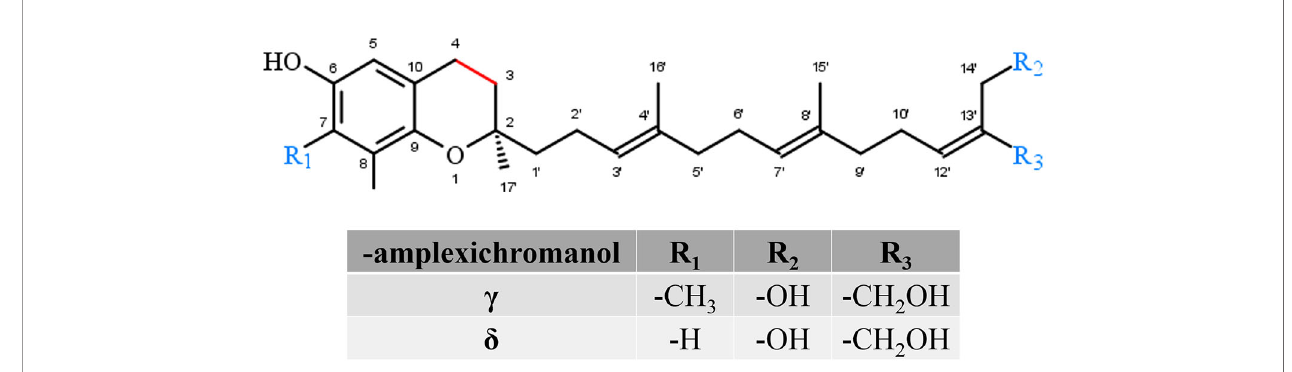
FIGURE 5 | Core structure of amplexichromanol forms.